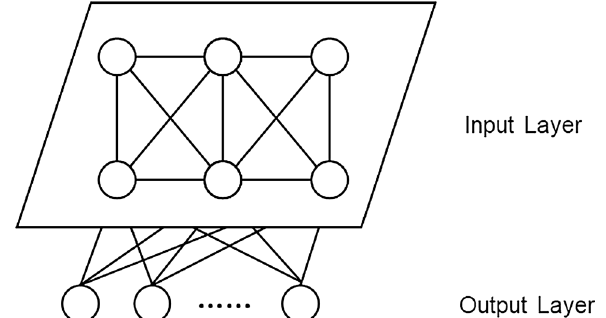
Fig. 1 Network structure of the self-organizing feature map